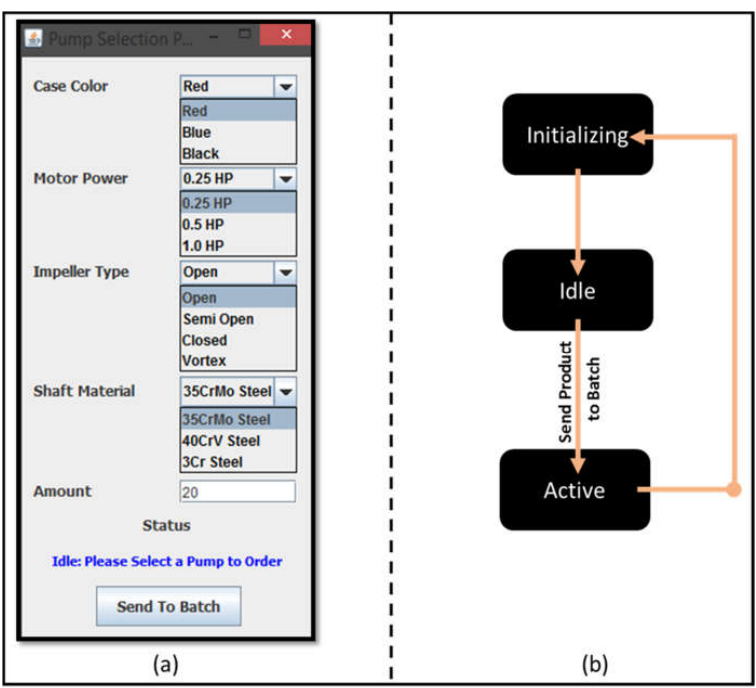
Figure 5. ( a ) PH (Product Holon) User Interface; ( b ) PH State-Machine.